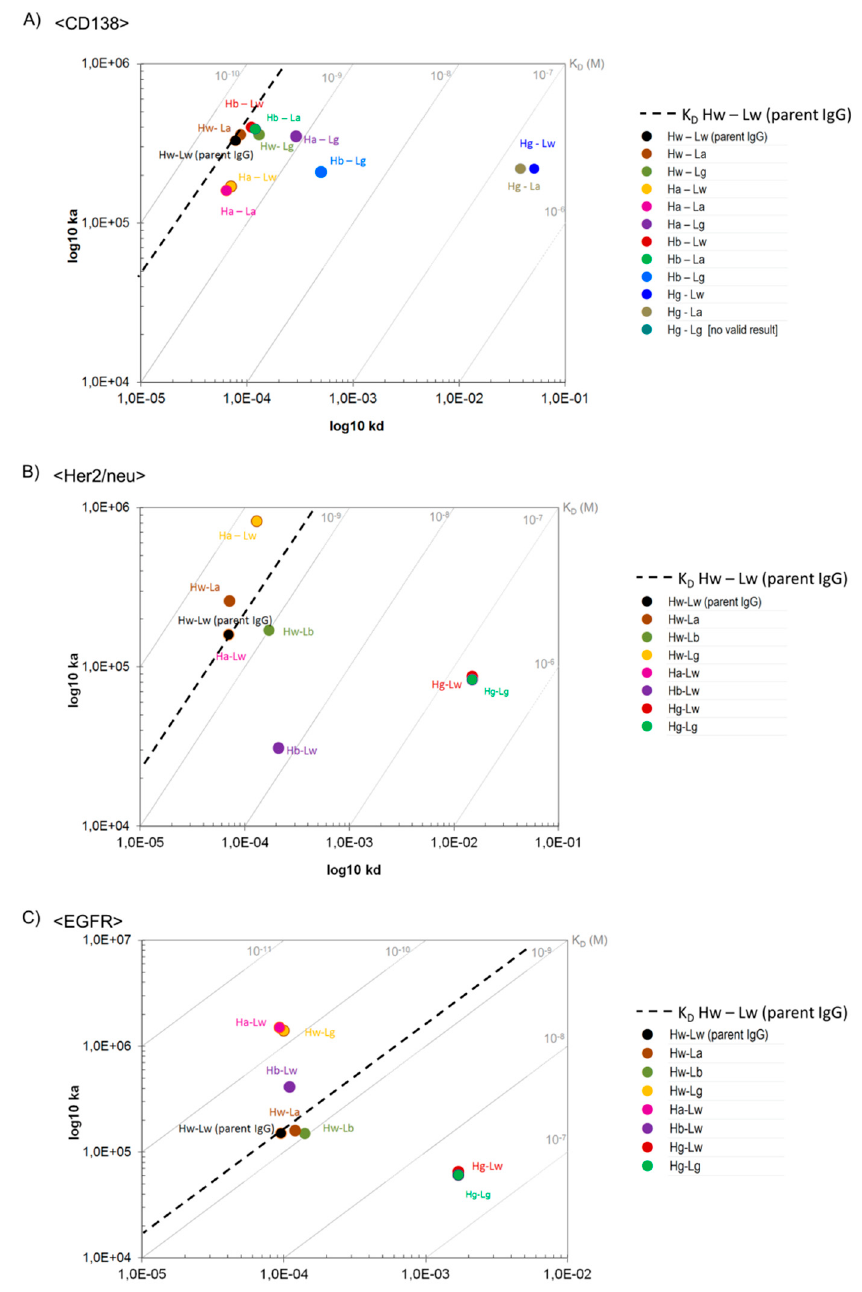
Figure 4. On-/Off-rate plots showing bivalent binding of B2GL variants to antigens. Surface Plasmon Resonance was applied to measure differences in binding kinetics of ( A ) <CD138>, ( B ) <Her2/neu>, and ( C ) <EGFR> variants. As a reference, note the dashed line indicating K D values of parental IgGs.